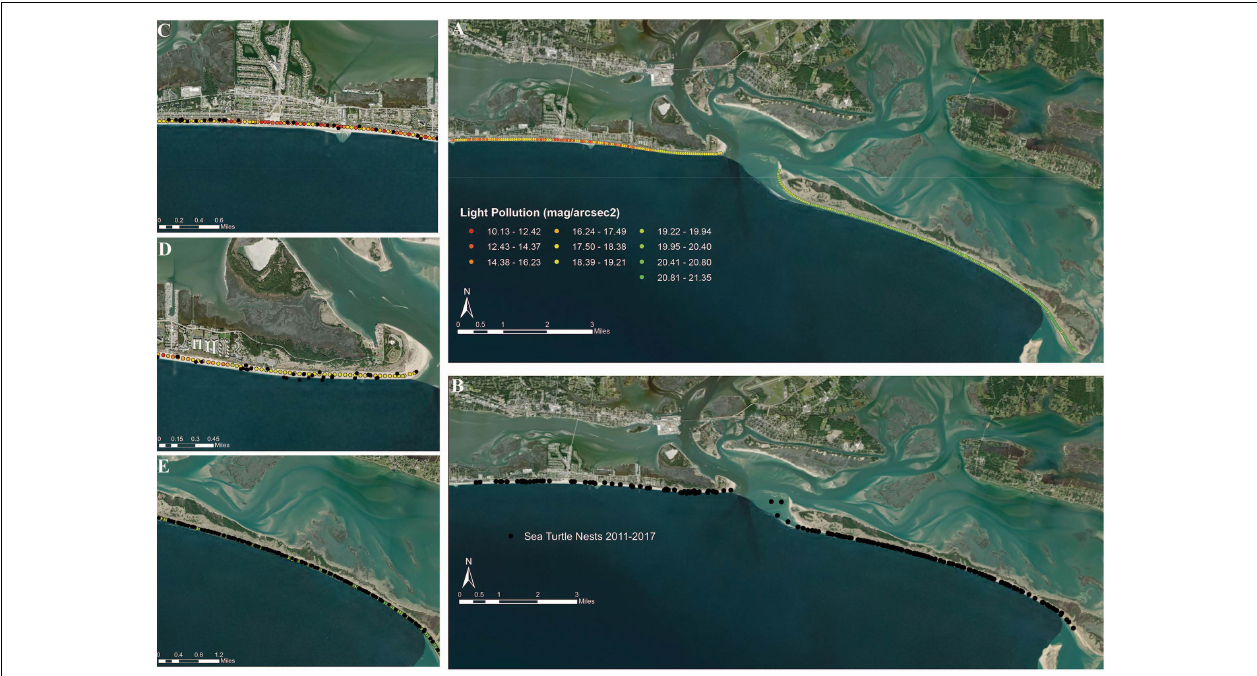
FIGURE 3 | (A) Light pollution values (mag/arcsec 2 ) taken every minute on autonomous terrestrial rover on study sites in summer 2017. Low mag/arcsec 2 values indicate high light pollution. (B) Verified nest locations on study sites from 2011 to 2017. (C–E) Enlarged map insets illustrating the increase of total nesting density (nests/year) from 2011 to 2017 as light pollution levels increase on (C) Atlantic Beach, (D) Fort Macon State Park, and (E) Shackleford Banks. Black dots represent 2011–2017 sea turtle nests overlaid on color dots representing light.